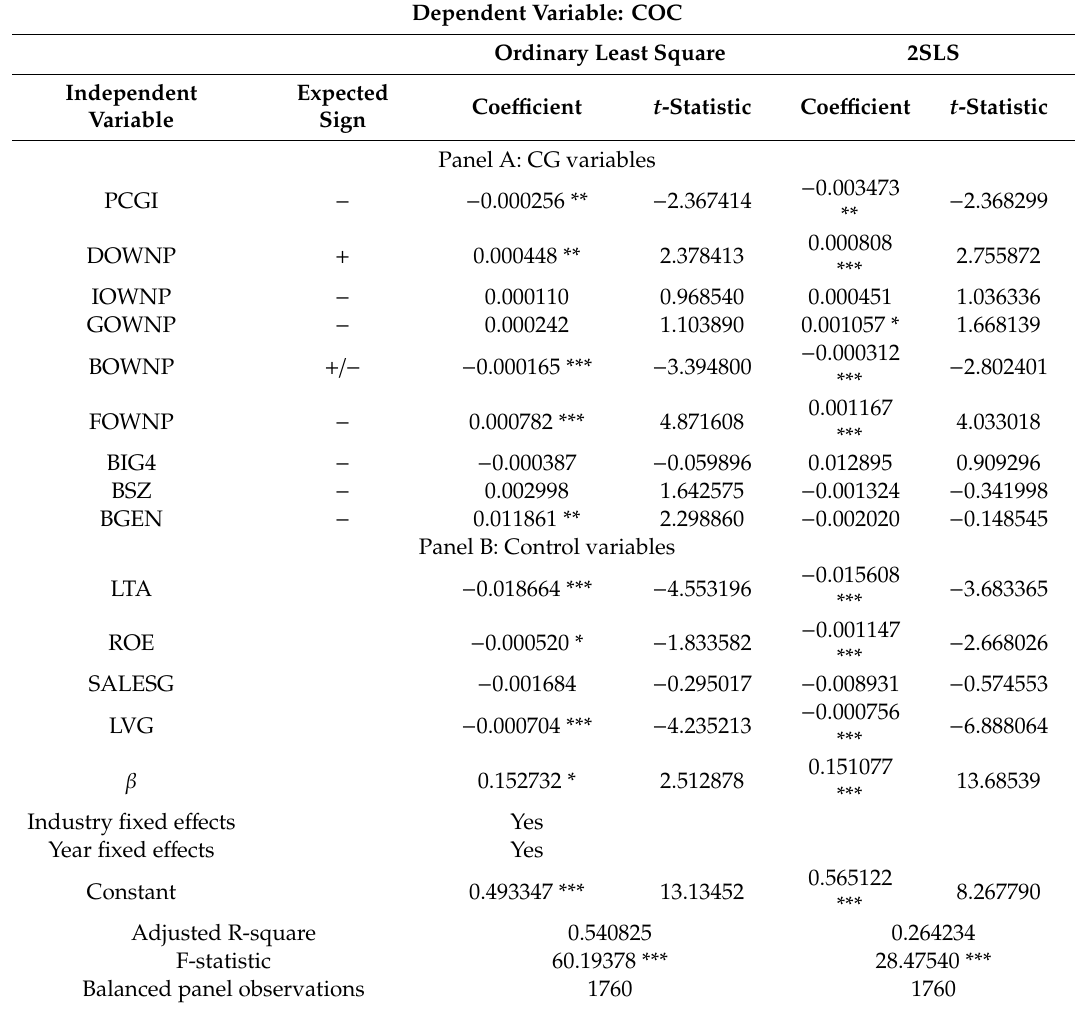
Table 7. Two-stage least-square